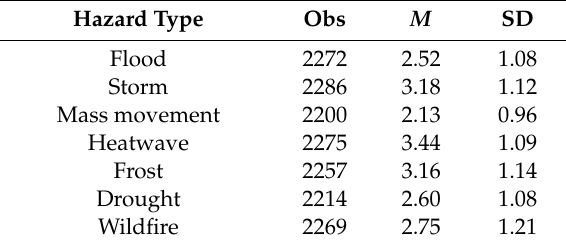
Table 7. Descriptive data for the variable of individual’s trust in warning for climate-related hazards’ risk. Table7. Descriptivedataforthevariableofindividual’strustinwarningforclimate-relatedhazards’risk.